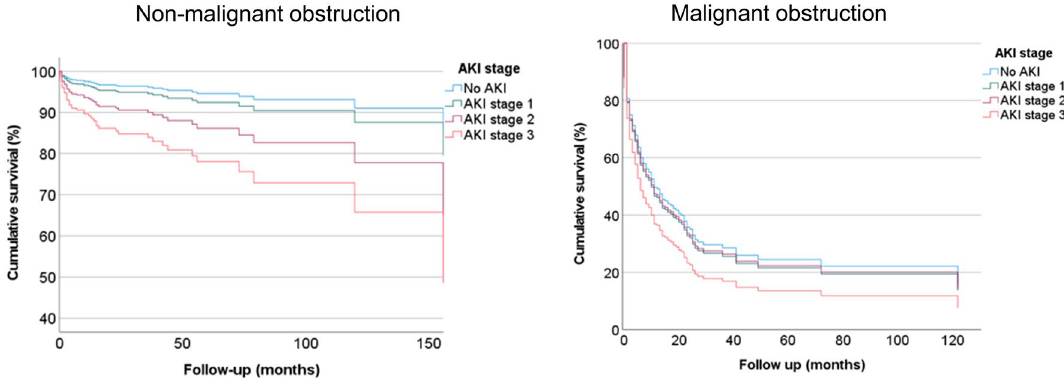
Figure 2. Cumulative survival of patients with obstructive uropathy according to AKI. The cumulative survival rates varied significantly with the AKI phase in non-malignancy related PCN. However, it was not different in malignancy related PCN.